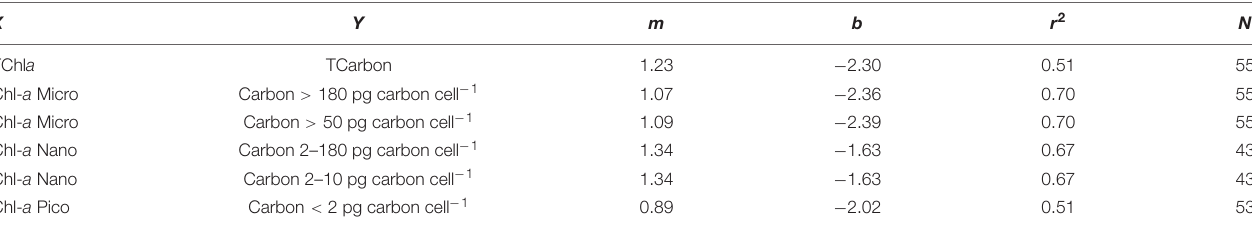
TABLE 4 | Results of linear regression Type II of log10-transformed carbon and log10-transformed Chl a for the total data set, as well as for the matching size classes estimated by the pigment or carbon approaches.